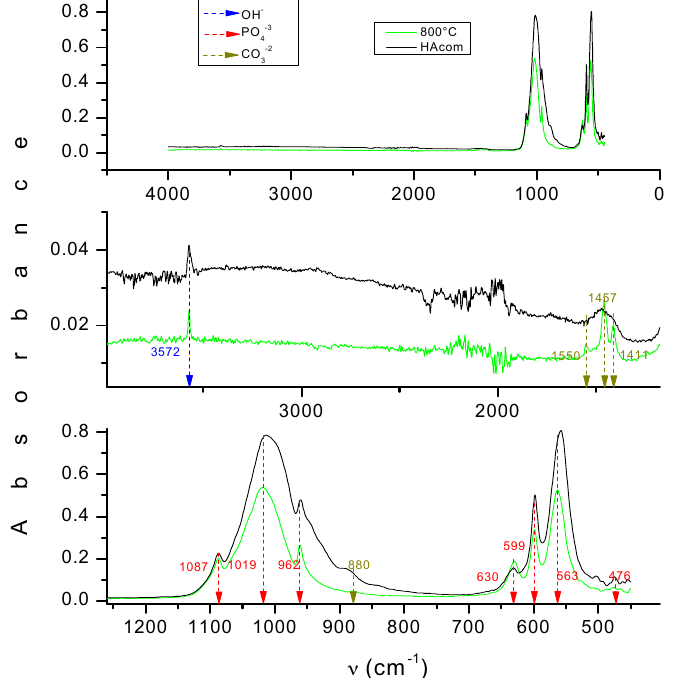
Figure 2. Fourier transform infrared spectroscopy (FTIR) spectra of HA obtained from bovine bones at 800 °C.